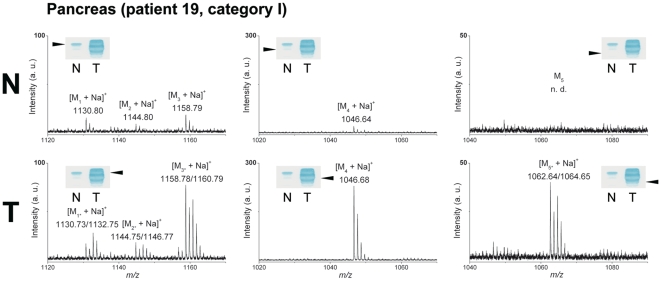
Tracing tumor-associated Gb3Cer/CD77 species in pancreas cancer.Lipid extracts equivalent to 2 mg wet weight of normal (N) and tumor tissue (T) of patient 19 (tumor category I, see Table 1 and Supplementary Table S1) were simultaneously separated by TLC followed by overlay analysis using Stx1. The Stx1 positive Gb3Cer/CD77 bands, which are marked with arrowheads in the insets, were analyzed by TLC-IR-MALDI-MS. The prevalent [M3*+Na]+ molecular ions of the upper band of the tumor tissue (T, left panel) correspond to Gb3Cer (d18:1/d18:0, C24:0) and the minor ions could be assigned to Gb3Cer (d18:1/d18:0, C23:0) and Gb3Cer (d18:1/d18:0, C22:0), respectively. In the upper band of normal tissue (N, left panel) much lower intensities of these molecular ions were observed. The high abundant [M4+Na]+ ions of the lower band in the tumor (T, middle panel) represent Gb3Cer (d18:1, C16:0), which is detectable only in trace quantities in normal tissue (N, middle panel). Analysis of the lowest band of the tumor (T, right panel) revealed [M5*+Na]+ ions, which are indicative for hydroxylated Gb3Cer (d18:1/d18:0, h16:0). This Gb3Cer/CD77 variant was undetectable in normal tissue (N, right panel). The m/z values of molecular ions and proposed structures of Gb3Cer/CD77-variants of malignant and adjacent normal tissues as well as references from human erythrocytes are listed in Supplementary Table S3.